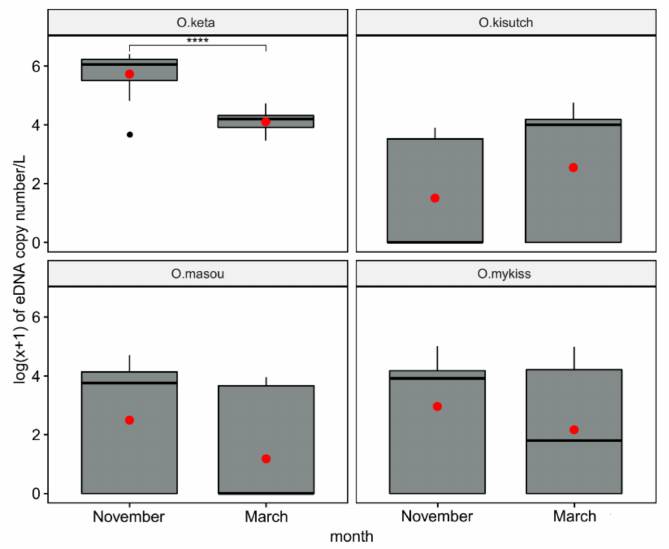
Figure 6. Log(x + 1) transformation of the inhibition-normalized eDNA copy number per liter of four species of Oncorhynchus in the Yangyangnamdae River compared by sampling event using whiskers plots. Means and medians are presented as red solid circles and horizontal solid lines within each box, respectively. Asterisks indicate the significance level ( p ) for each comparison by pairwise Wilcoxon rank-sum tests: **** p < 0.0001.